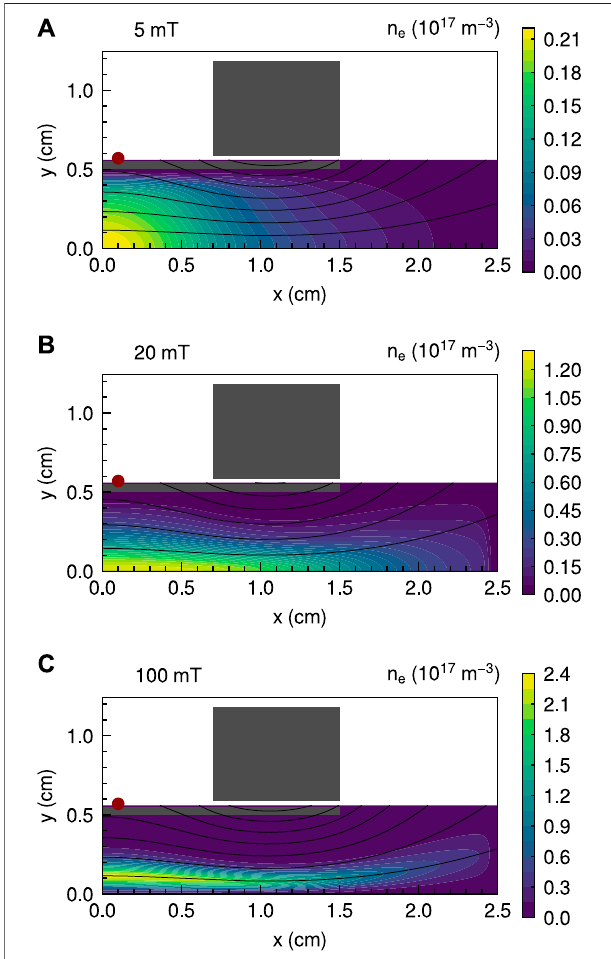
FIGURE 2 | x - y pro fi les of the electron number density n e for the three magnetic fi eld strengths of (A) 5, (B) 20, and (C) 100 mT. Solid black lines show magnetic fi eld lines.